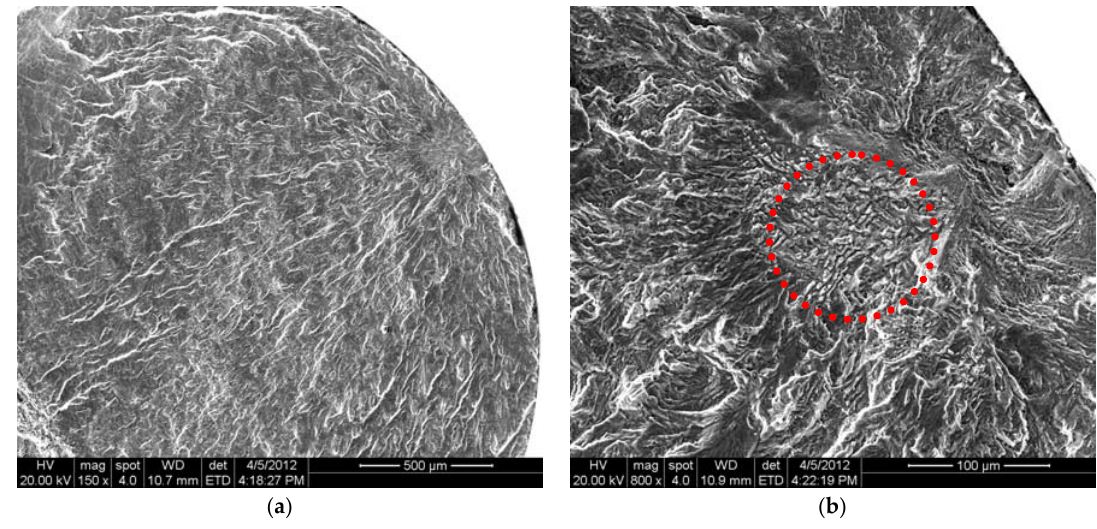
Figure 6. Fatigue fracture surface of TC21 titanium alloy with basketweave of 40 μ m at σ = 540 MPa, N = 8.51 × 10 7 cycles: ( a ) fatigue crack initiation site; ( b ) high magnification morphology.